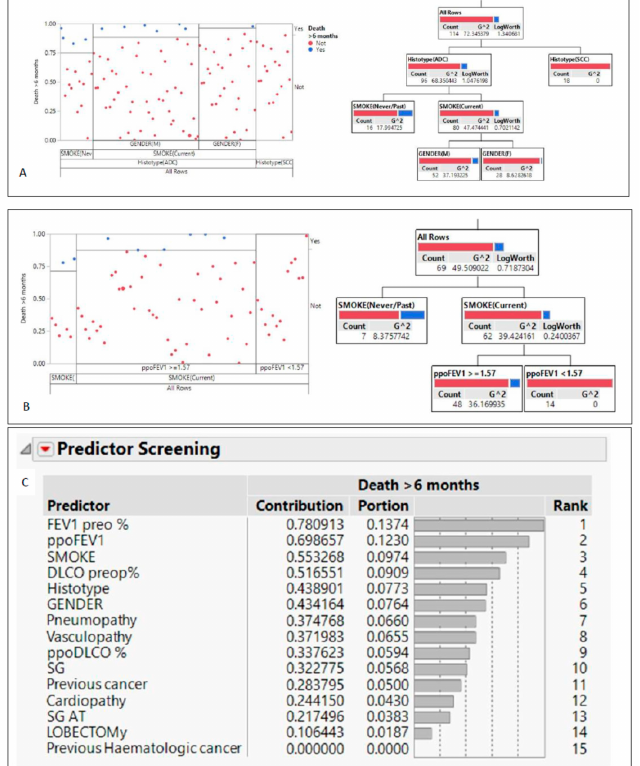
Figure 2. Partition analysis and variable ranking applied to the dataset. ( A ) In raw analysis of the whole cohorts undergoing surgery, squamous cell cancer and stage IA were the factors most associated with better outcomes; ( B ) smokers with the worst lung function and harboring adenocarcinoma had better survival than never smokers; ( C ) predictor ranking analysis applied to the whole cohort indicates FEV1 and smoking as the most relevant variables that impact the 6-month